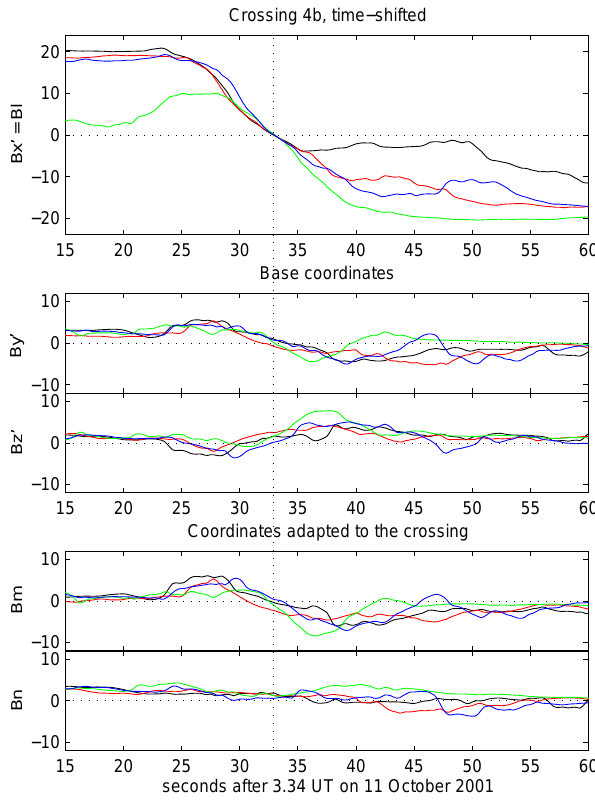
Fig. 7. The magnetic field components measured by Cluster during the crossing 4b in Fig. 5. The data have been time-shifted so that the B x 0 = B l sign changes coincide; the time axis gives real time for C1. In the two lowermost panels the coordinates have been rotated to show the Hall effect in B m . Colouring of the lines as in Figs. 5a–c and 6. of the strongest fluctuations in B z 0 coincide with B x 0 sign changes and consist of a negative peak followed immediately by a positive one. Figure 7 examines in detail one such cross- ing, 4b in Table 2 and Fig. 5. The data from Cluster 2, 3 and 4 are time-shifted so that the B x 0 sign changes coincide. The first three panels show the magnetic field components during the crossing in the coordinates x 0 y 0 z 0 , same as in Fig. 5. Bipolar variation is seen in both B y 0 and B z 0 . Then another rotation of 43 ◦ , in a left-handed sense around the x 0 axis, was applied to the coordinate axes. The angle was chosen to remove correlation between the second and third magnetic field components, denoted B m and B n in these new coordinates lmn . Table 3 gives the orientations of these axes in GSM coordinates. The n axis is approximately aligned with the current sheet normal given by timing analysis (cf. Table 2); the cosine of their angle is 0.97. B m and B n are shown in the two last panels of Fig.